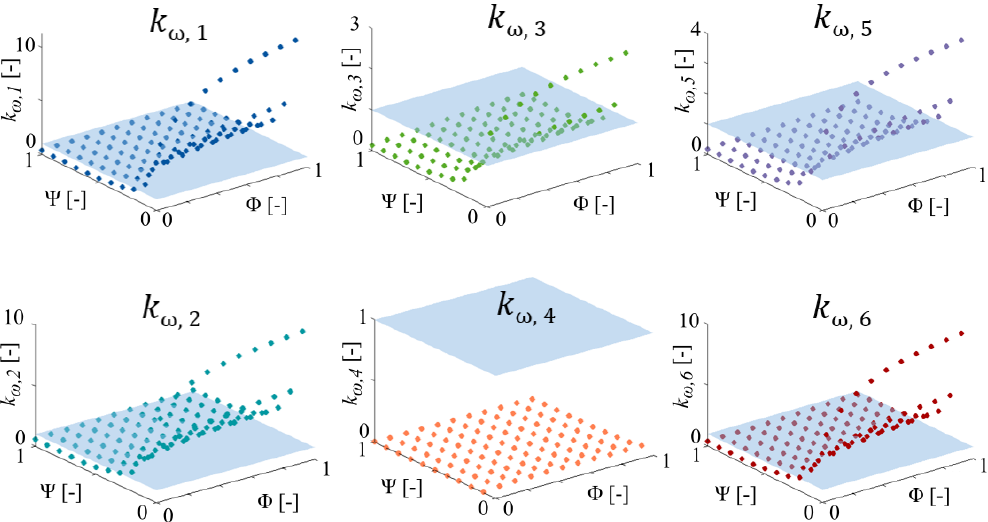
Figure 23. Influence of Φ and Ψ on k ω , i for all robot joints. The light blue plane shows k ω , i = k ω , i , crit = 1 under which the path is manipulable.